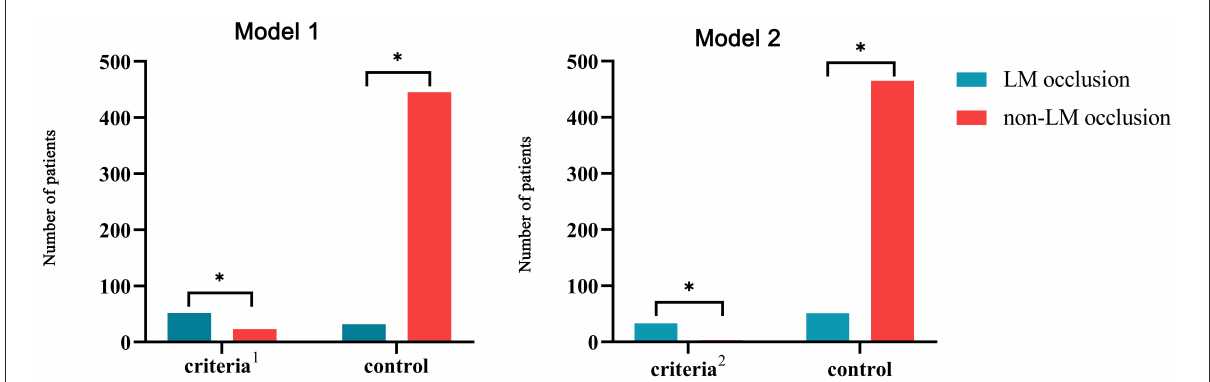
FIGURE3 Combining ECG criteria for the prediction of LM occlusion. Model 1: Combination of two STE criteria (STE in both aVR and aVL and STE in I, aVL, V2–V5 without V1); Model 2: combination of two STE criteria and two fascicular block criteria (STE in both aVR and aVL plus LAFB, STE in both aVR and aVL plus LAFB + RBBB, STE in I, aVL, V2–V5 plus LAFB, and STE in I, aVL, V2–V5 plus LAFB + RBBB). LM, left main coronary artery; STE, ST-segment elevation; RBBB, right bundle branch block; LAFB, left anterior fascicular block. * p < 0.05.